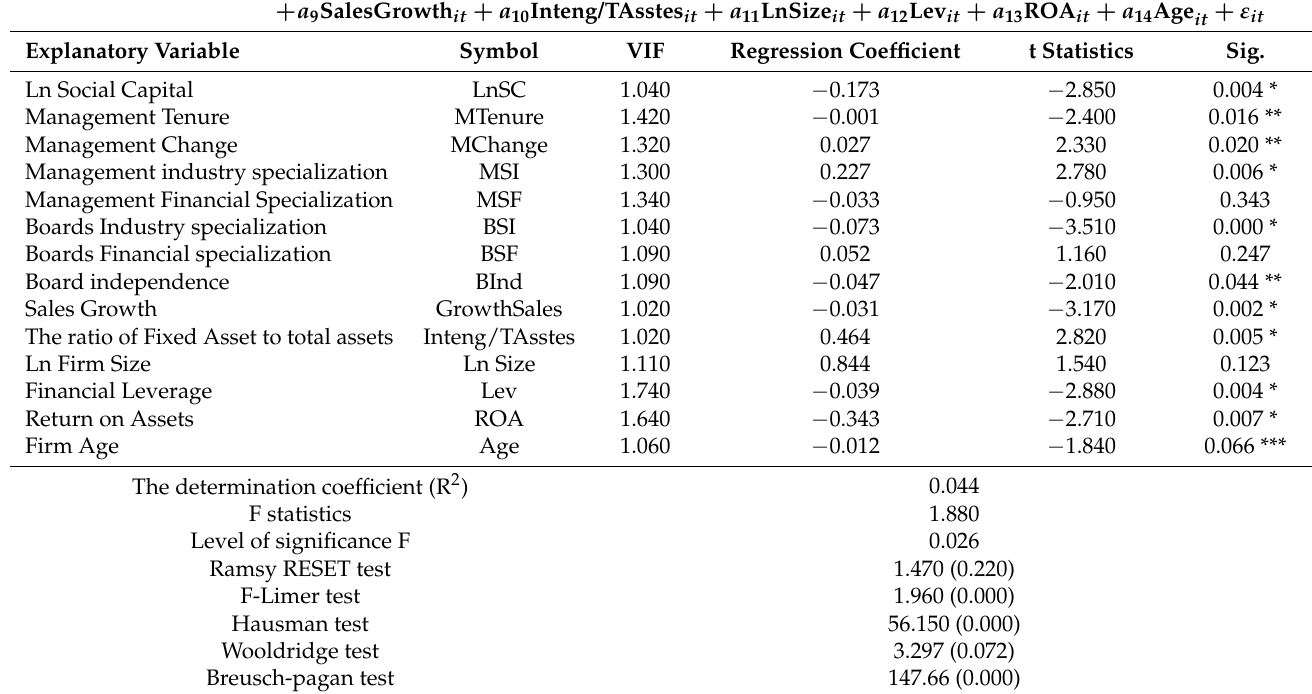
Table 6. The Results of testing the third hypothesis